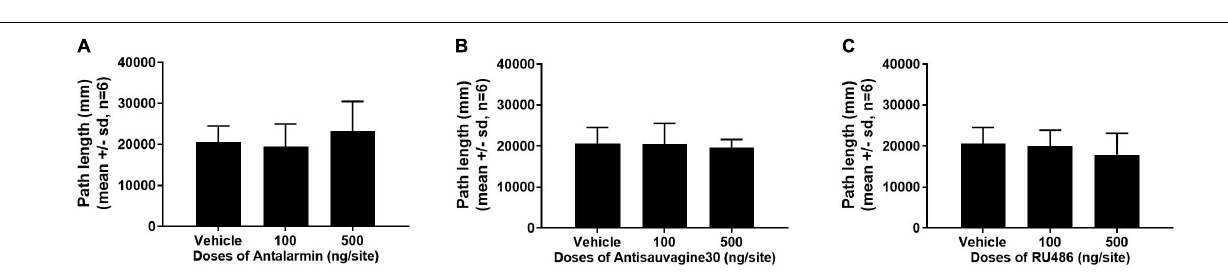
FIGURE 6 | The pretreatment with antalarmin (A) , antisauvagine 30 (B) , or RU486 (C) at the bilateral lateral ventricle did not cause any difference that reached significance of the numbers of active nose-poke responses, food tray, and inactive nose-poke responses in the rats that receive tail clip stressful stimulation compared with the vehicle group. The normally distributed data were analyzed with one-way ANOVA, otherwise was analyzed with a Kruskal–Wallis test. SD, standard